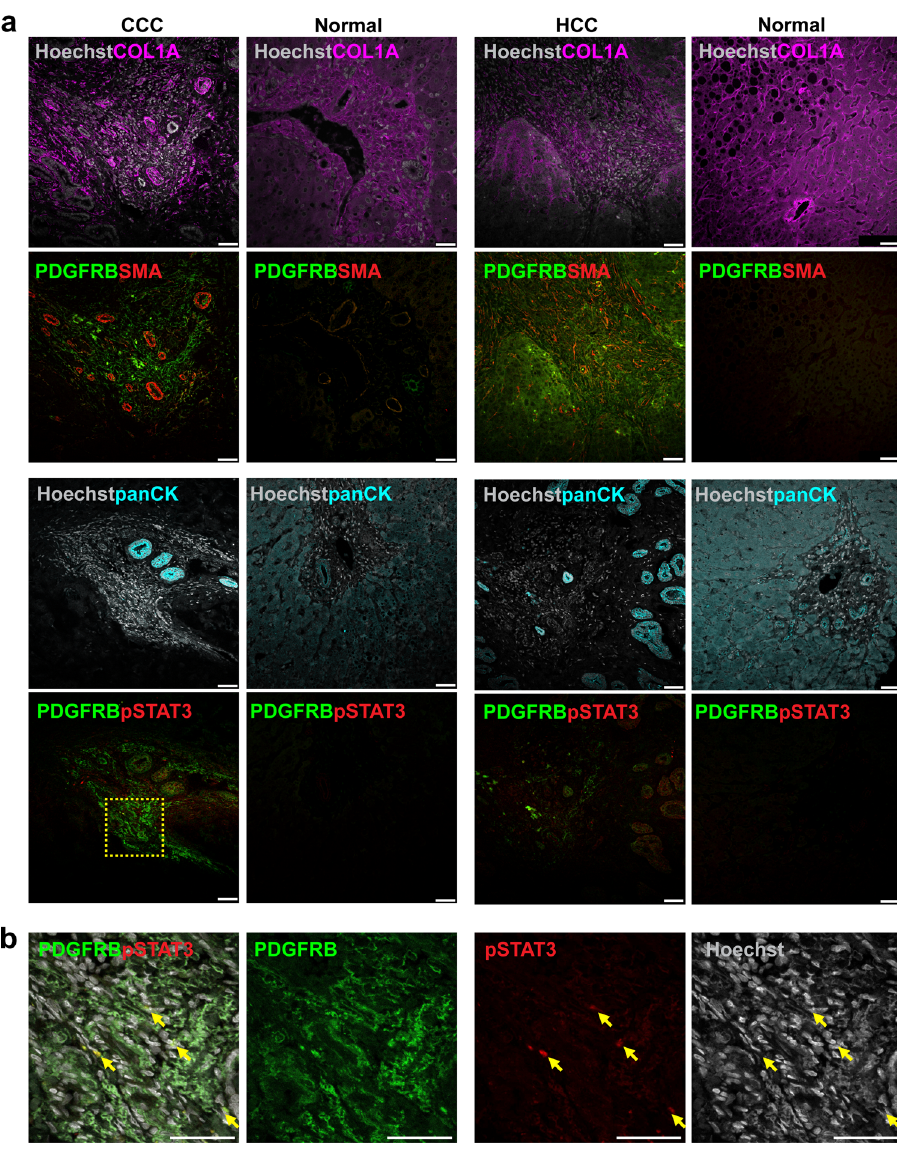
Fig. 6 The PDGFRB-STAT3 pathway is activated in myo fi broblasts in human liver cancer tissue. a Resected liver tissue obtained from patients with hepatocellular carcinoma (HCC) or cholangiocarcinoma (CCC). The tumor and adjacent normal tissues were immunostained with antibodies to PDGFRB, smooth muscle actin (SMA), and collagen 1A (COL1A); or with pan cytokeratin (panCK), PDGFRB, and phospho-STAT3 (pSTAT3) antibodies. a PDGFRB expression was much higher in the tumor tissues than in the adjacent normal liver tissue. While pSTAT3 expression was undetectable in the normal liver tissue; low levels of pSTAT3 staining within/near PDGFRB + cells were seen in the CCC tumor tissue. b An enlarged view of the dashed square region of the CCC tumor tissue (in a ) is shown. This region has abundant PDGFRB expression within the CCC tumor, and pSTAT3 is detected in an area with PDGFRB + cells (indicated by the arrows). Scale bar, 50 μ